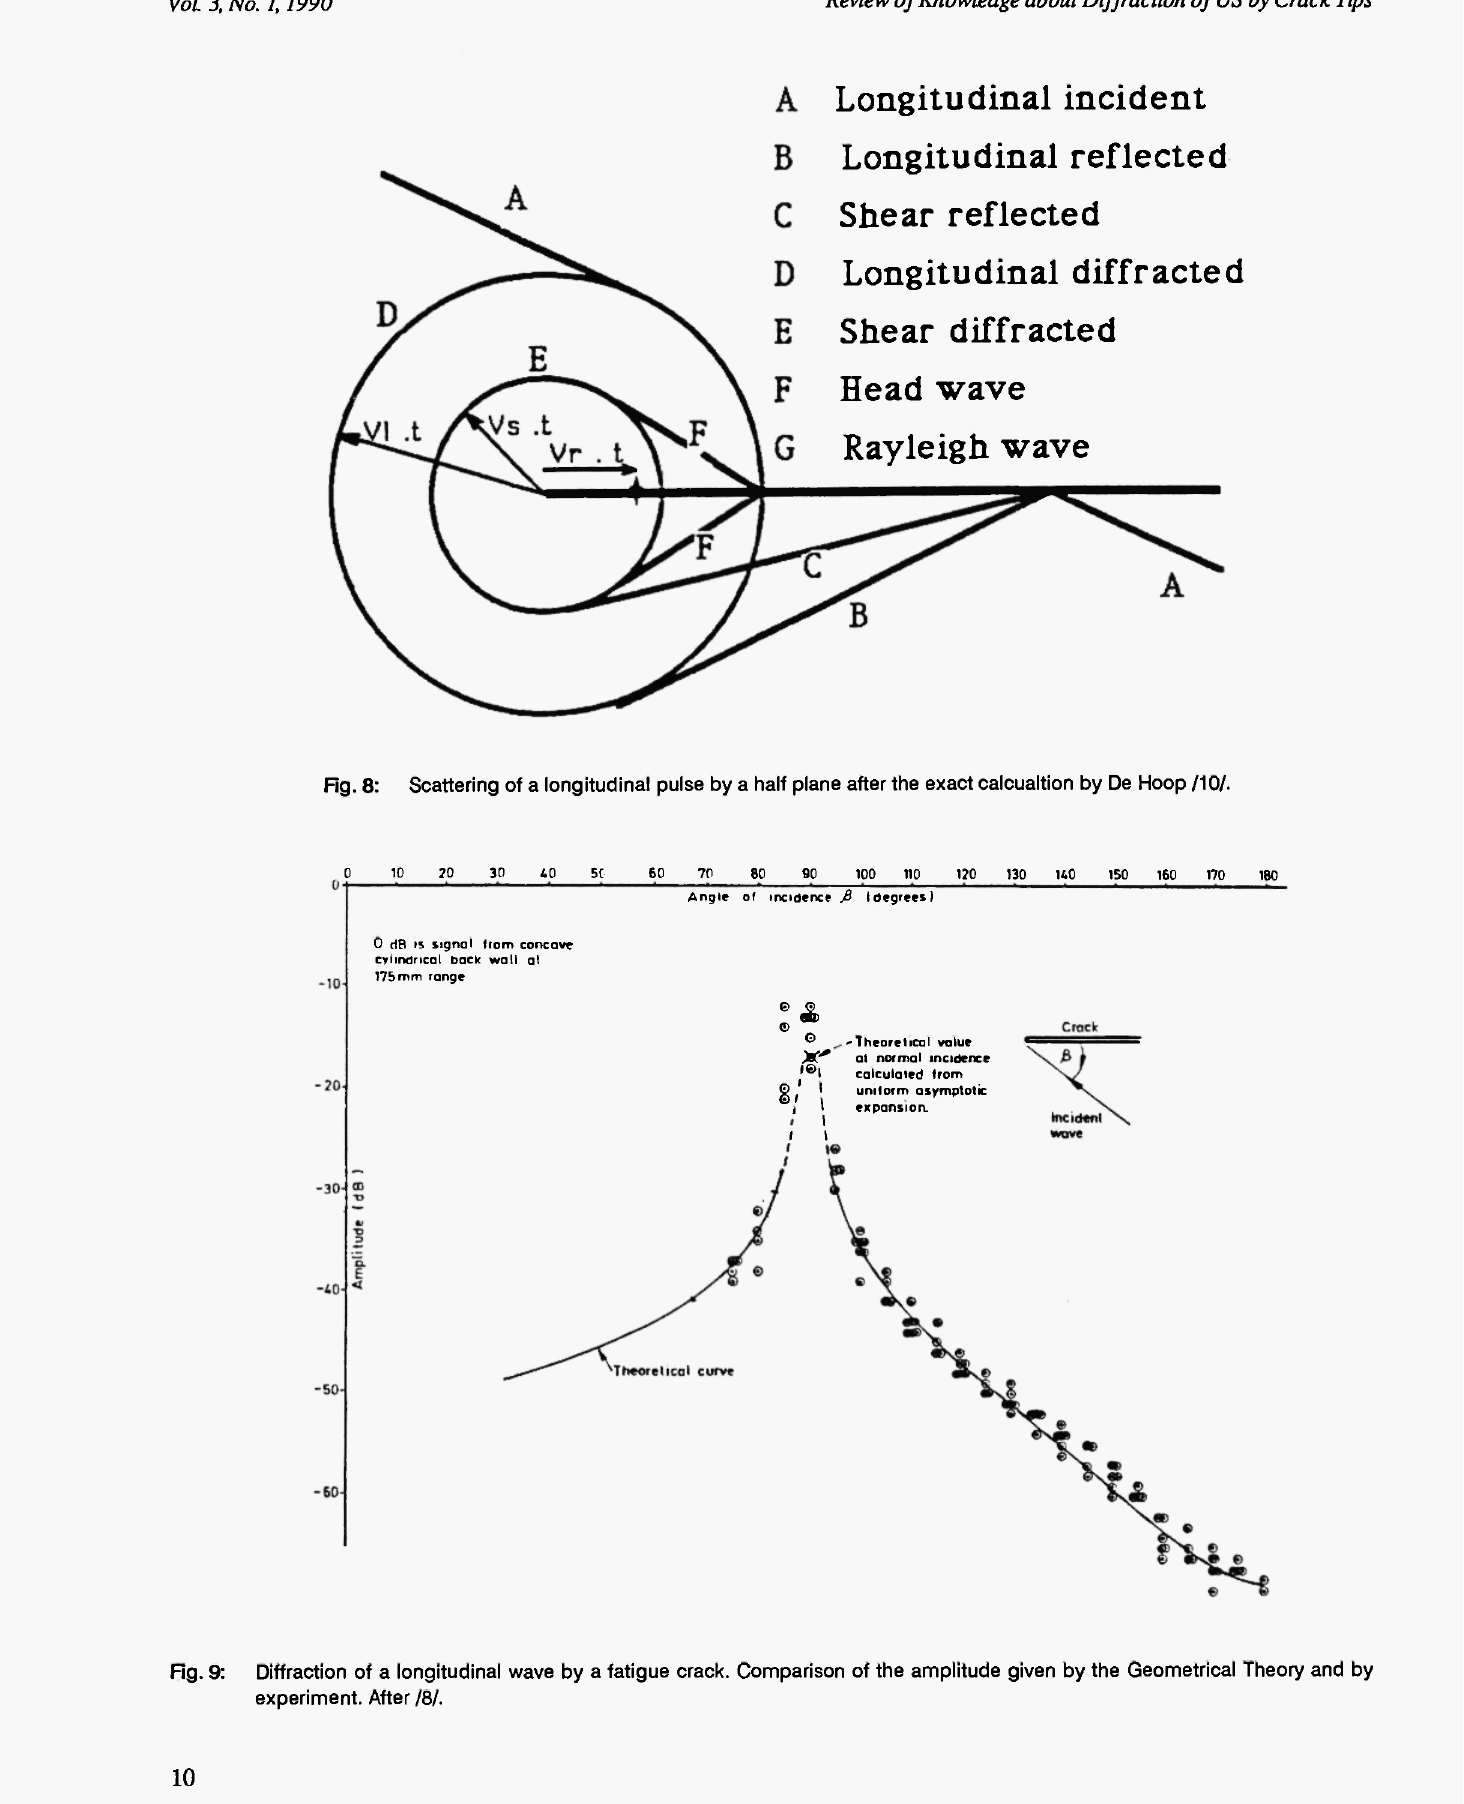
Fig. 9: Diffraction of a longitudinal wave by a fatigue crack. Comparison of the amplitude given by the Geometrical Theory and by experiment. After